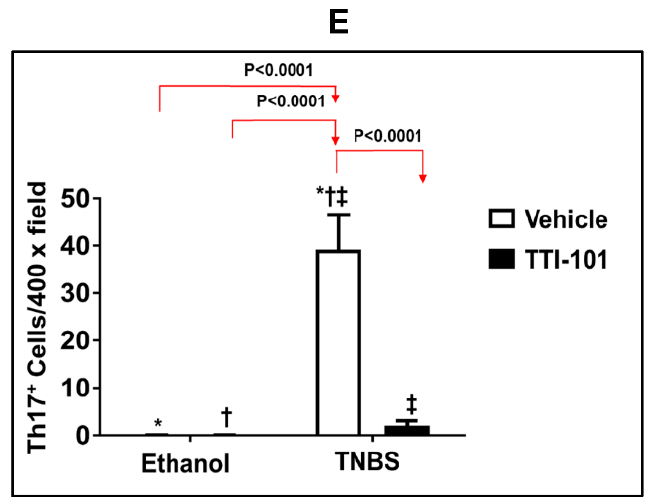
Figure 5. Effect of TTI-101 treatment on colonic Th17 cell infiltration. ( A ) Photomicrographs of Th17-stained sections of colons derived from control mice without TTI-101 treatment or ( B ) control mice with TTI-101 treatment or ( C ) TNBS mice without TTI-101 treatment, and ( D ) TNBS mice with TTI-101 treatment (magnification 400 × ). Red arrows depict cells positively stained for Th17. Scale bar on each micrograph represents 50 microns. ( E ) TTI-101 treatment significantly decreased levels of TNBS-induced colonic Th17 cell infiltration. Results are expressed as the mean ± SEM (average Th17 number in *, Ethanol vs. TNBS, † , Ethanol+TTI-101 vs. TNBS and ‡ , TNBS vs. TNBS+TTI-101, all, p < 0.05, ANOVA followed by Tukey’s post-test) ( n =